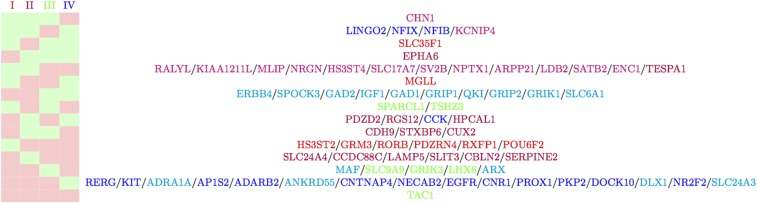
Experimental barcodes for clusters I - IV post data processing. For gene expression probabilities ≥0.5 code displayed as green and for gene expression probabilities <0.5 code displayed as red. Genes that display the same pattern across all four clusters are displayed on the same row. Genes are colored red, purple, green and blue for those expressed in clusters I - IV respectively. DEG that are expressed in both PN subtypes I and II are colored magenta and DEG expressed in both IN subtypes III and IV are colored cyan.